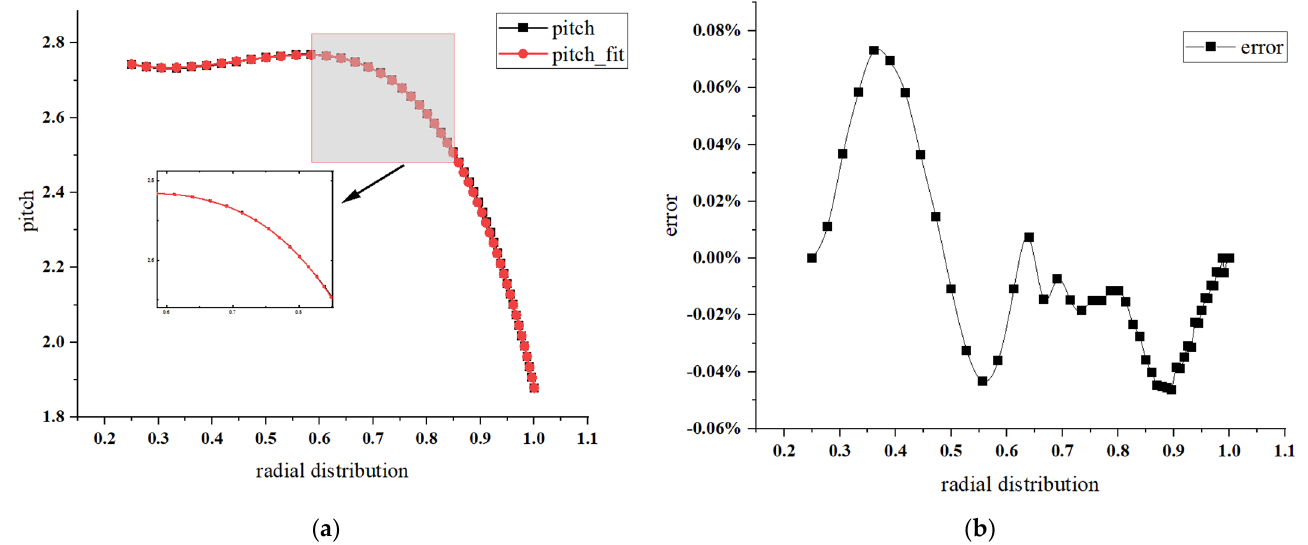
Figure 5. Comparison of chord length curve and chord length fitting curve: ( a ) curve comparison; ( b ) relative error.